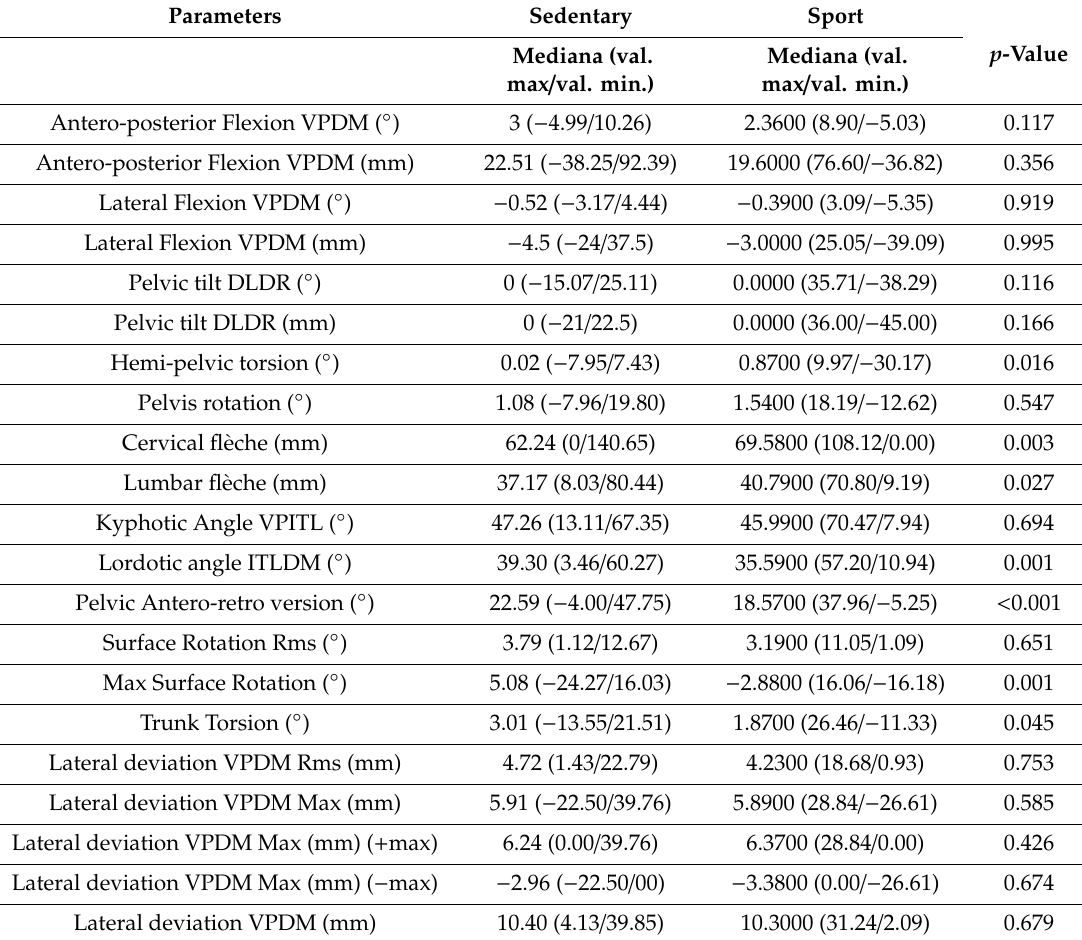
Table 4. Postural comparison between Sedentary and